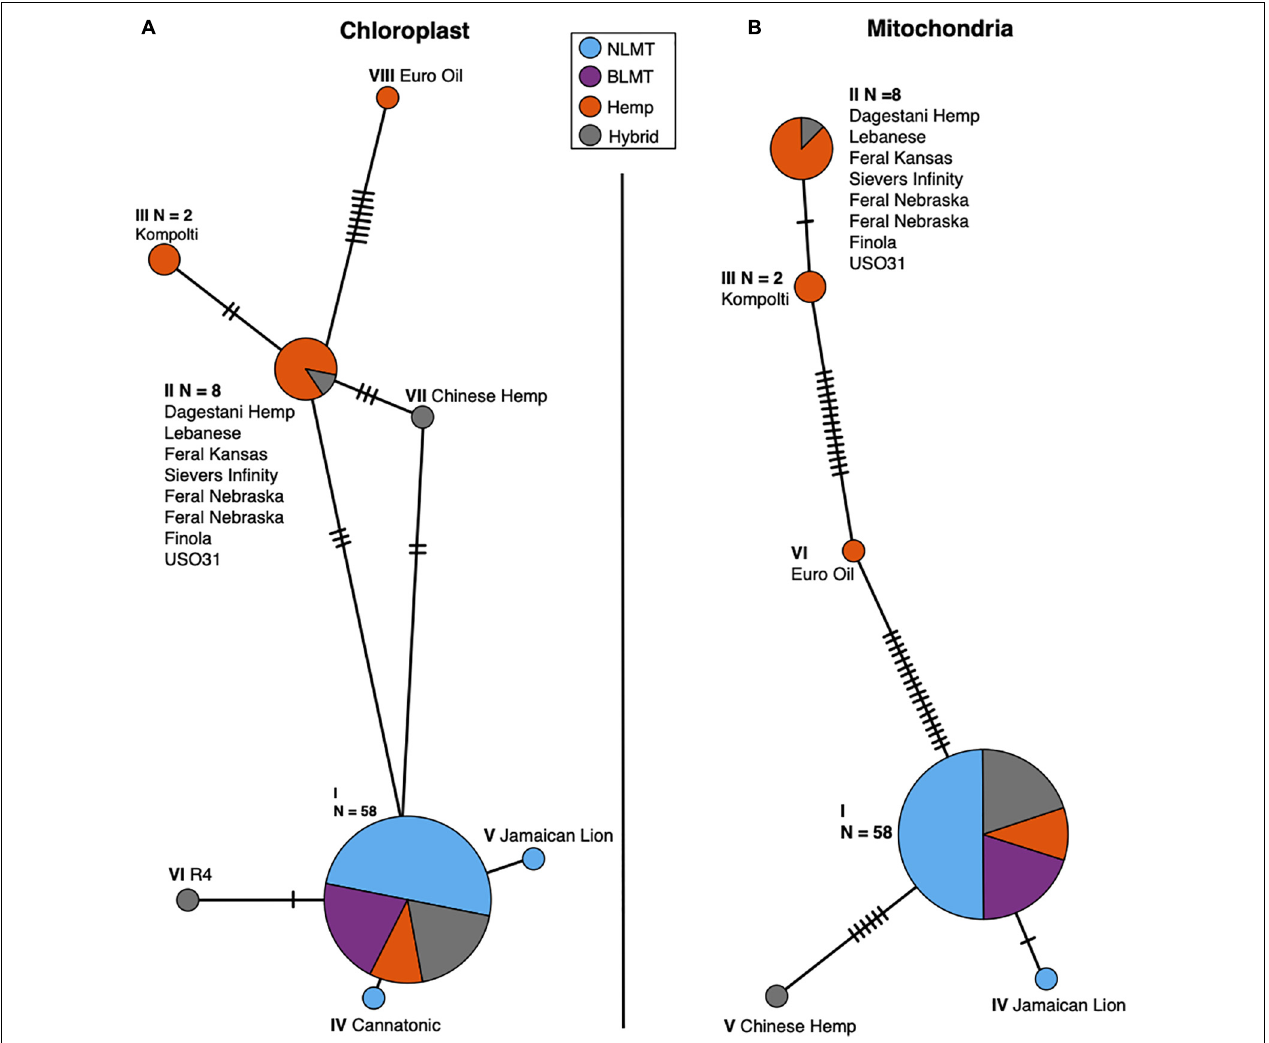
FIGURE 5 | Chloroplast (A) and Mitochondrial (B) haplotype networks. Both haplotype networks are similar with a common haplotype shared by most individuals (79 and 82% for the chloroplast and mitochondria, respectively) and smaller haplotypes that differ slightly, mostly comprised of Hemp